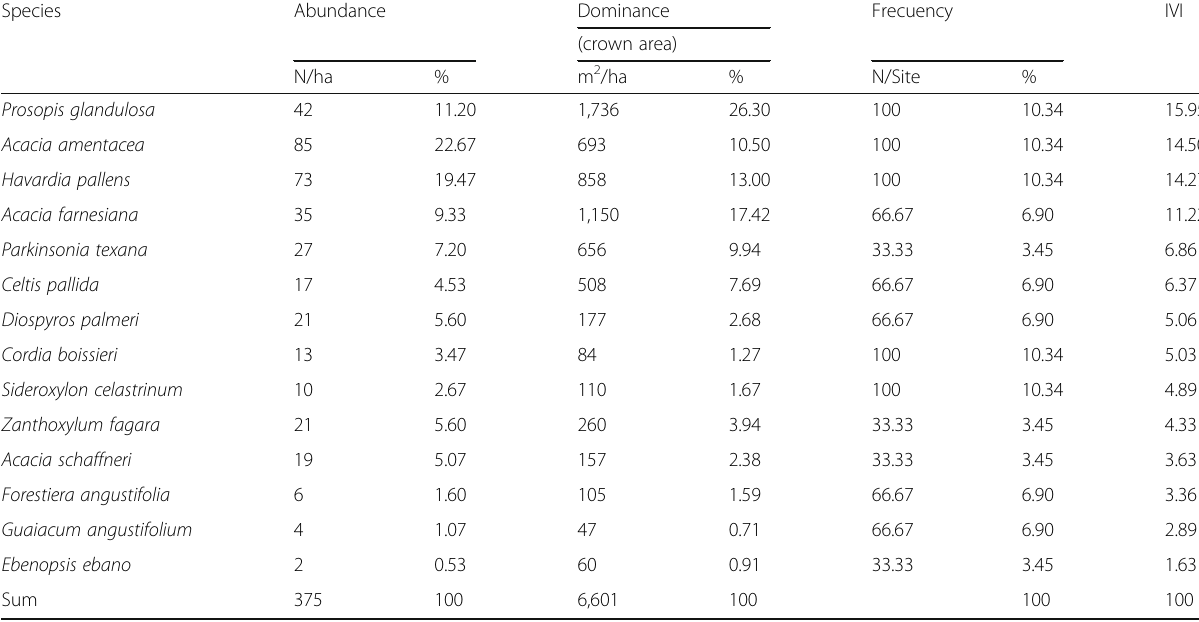
Table 2 Abundance, dominance, frequency, and Importance Value Index (IVI) of the species recorded (ranked according to their IVI value) Species